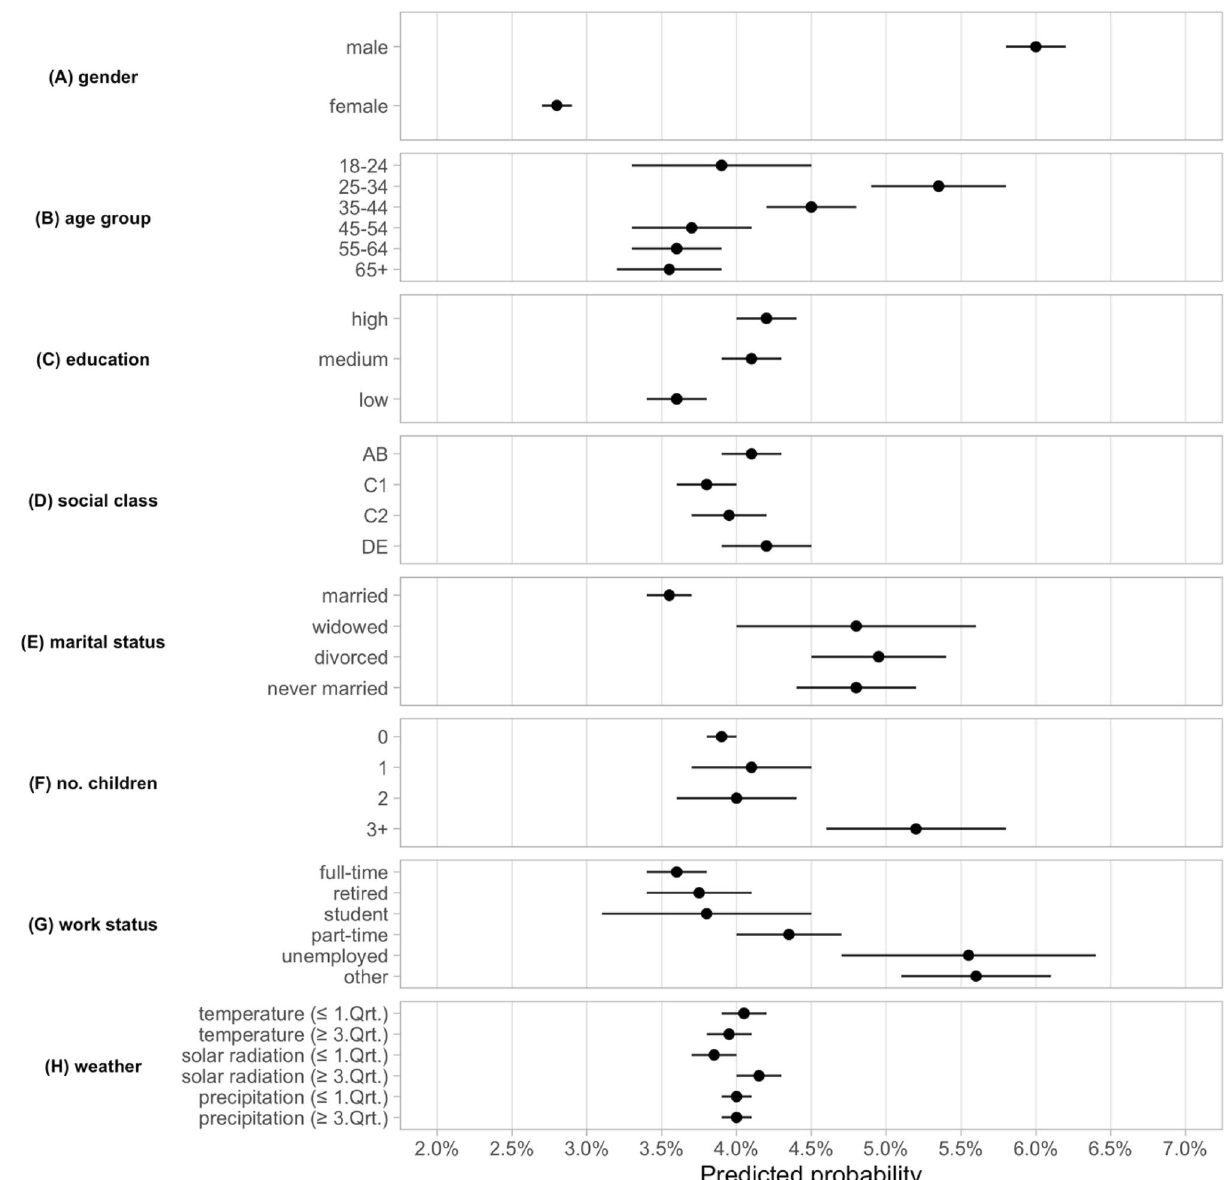
Figure 2. The predicted probabilities (in %) for non-compliance with lockdown policies were largest for male, young, unemployed, non-married ones or parents with more than two children. The plot shows the predicted probability of non-compliance when each individual level characteristic is equal to 1, while all other covariates are held constant at their mean values. The estimates are based on a logistic regression with date and region fixed effects included and robust standard errors clustered at the region level. The horizontal lines show the 95% confidence intervals. N =